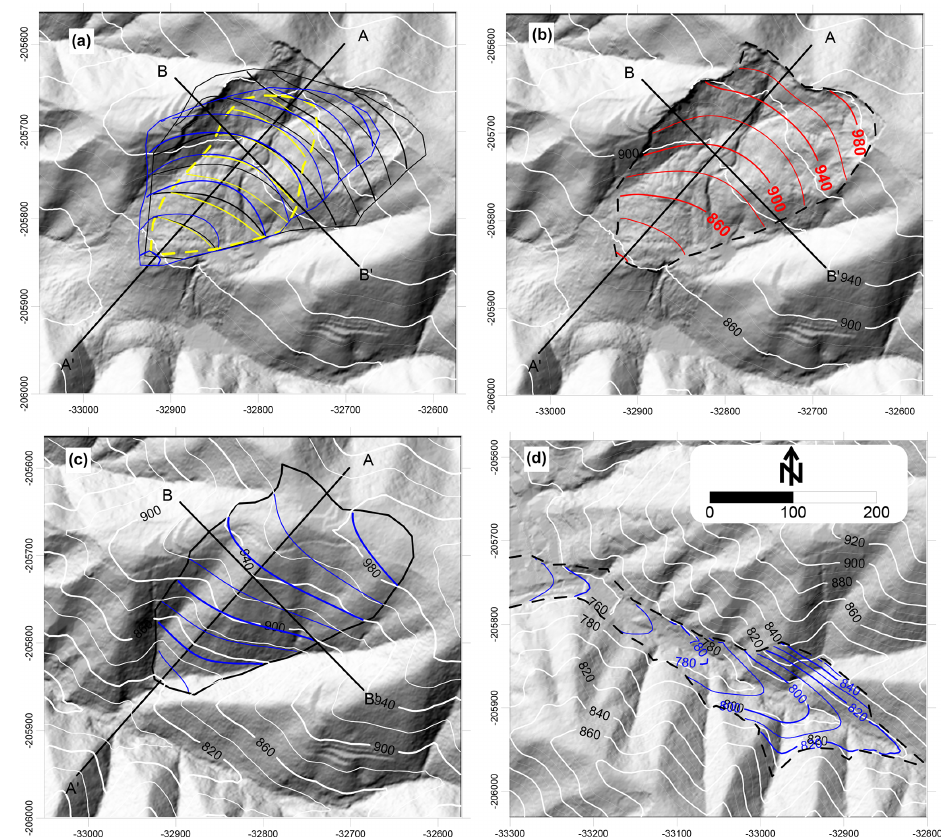
Figure 5. SLBL applications for the Kitamata landslide. (a) Failure surfaces of three scenarios based on the analysis of the topography before the 2011 landslide without post-failure information (SC1: yellow; SC2: blue; SC3: black). (b) Mixed scenario in red with the contour deduced from both the pre- and post-DEMs. (c) Reconstruction of the topography based on the post-DEM compared to that of the pre-DEM. (d) Reconstruction of the valley based on the post-DEM.